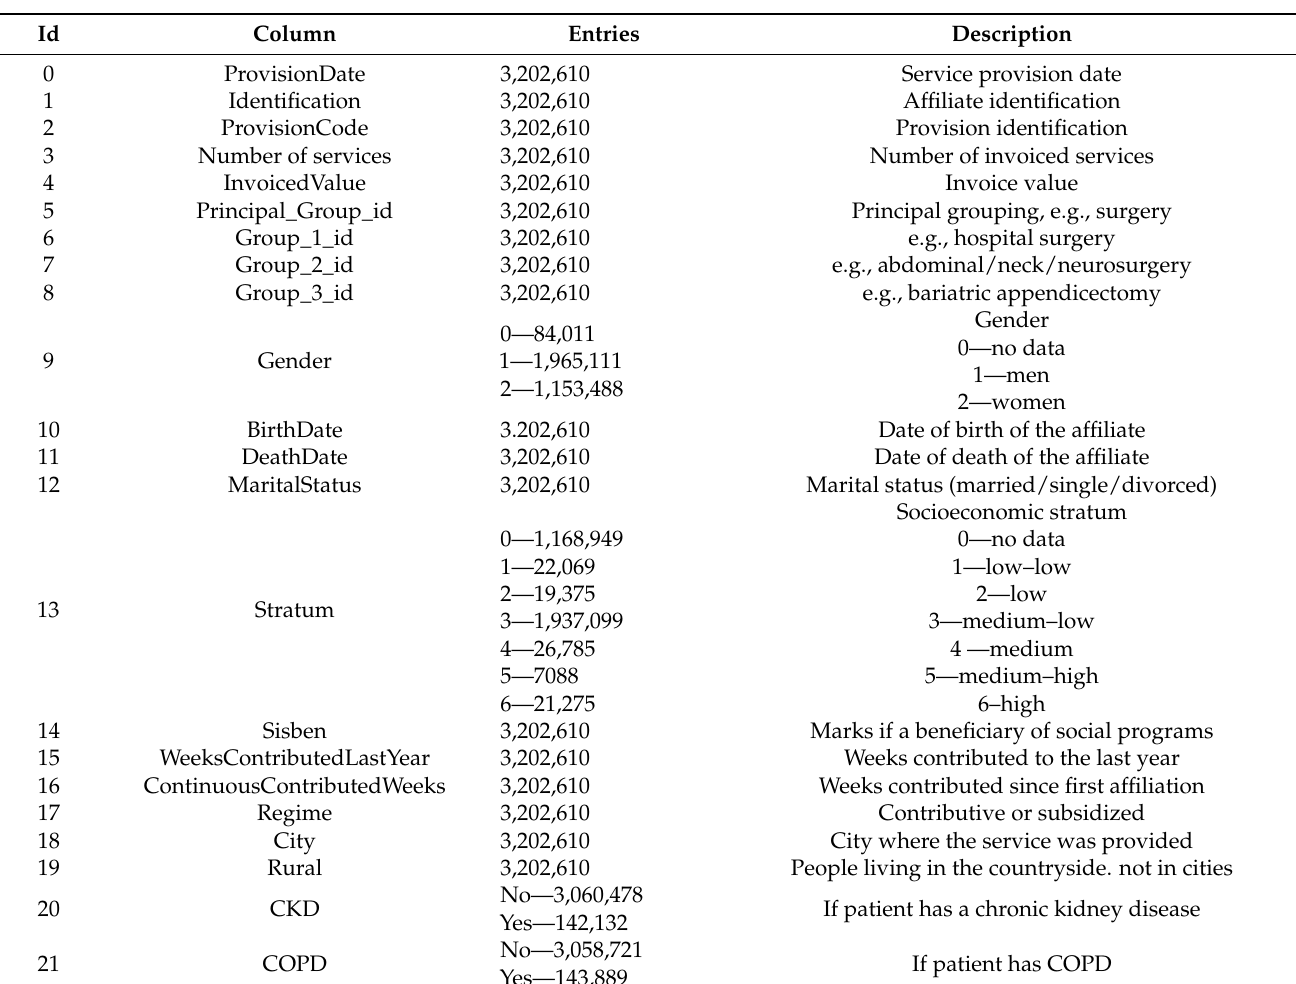
Table 2. Selected